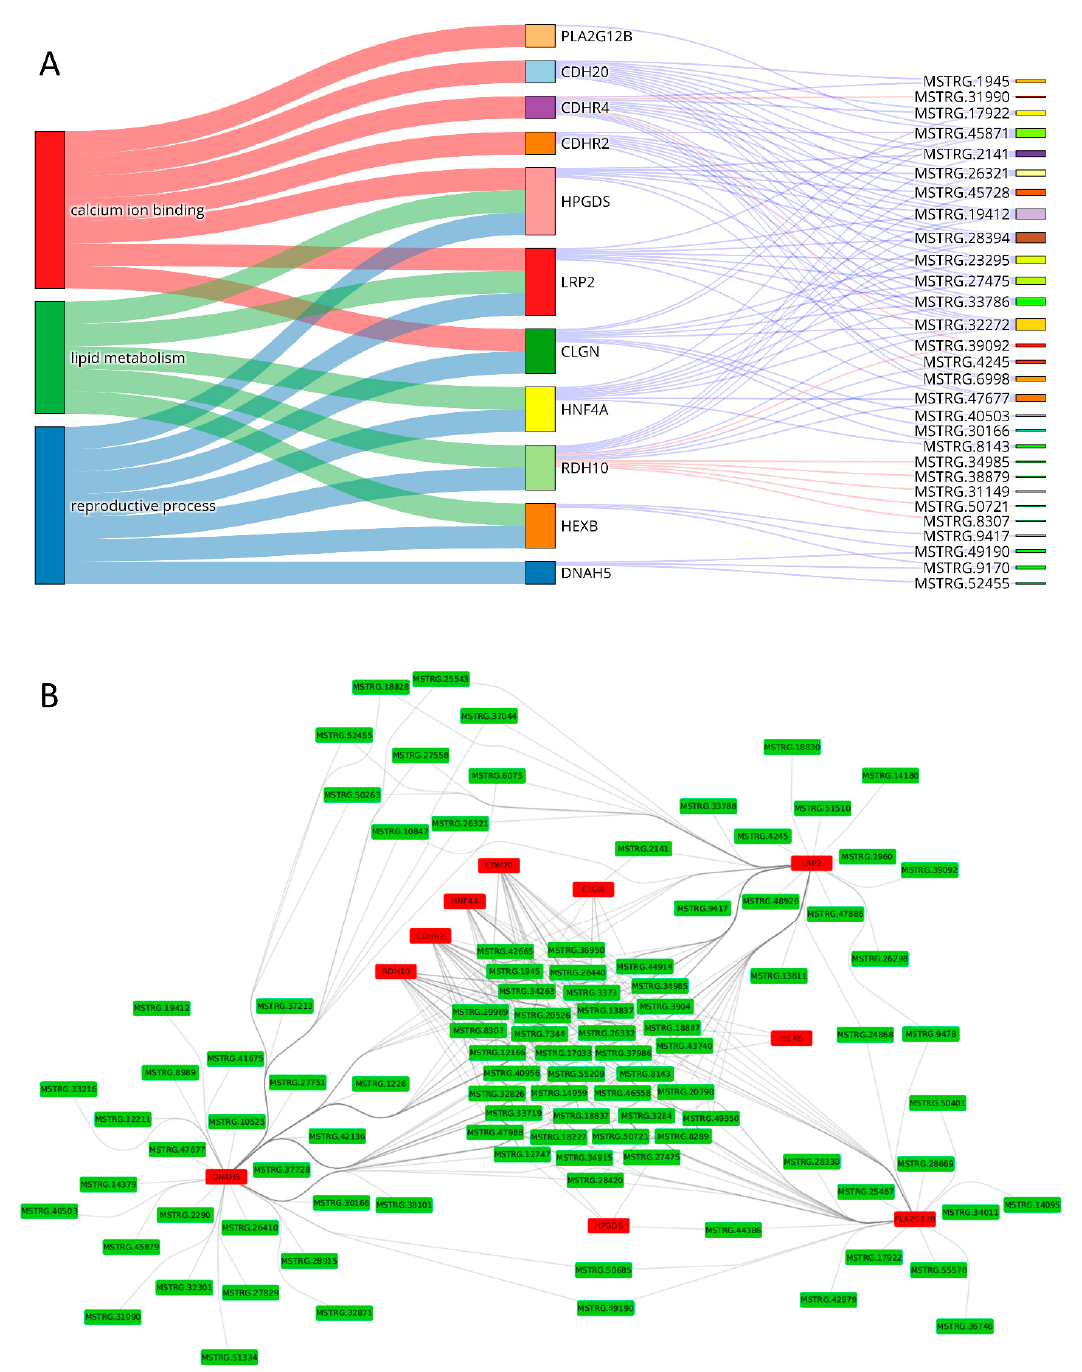
Figure 6. Trans-correlations ( A ) and direct lncRNA-mRNA interactions ( B ) identified in the group of processes with significantly expressed genes between DEGs and DELs associated with the E/(T + DD) group of molecular functions (see Table 4 and Figure 4). The first column in Figure A represents the biological processes. The second column shows the genes associated with the processes in the first column (the lines of the Sankey plot colored corresponding to the processes represent the gene– process relationship). The third column presents lncRNAs, and the lines connecting them with genes symbolize the expression correlation (blue—positive correlation, red—negative correlation). The green color in Figure B indicates lncRNAs, and red indicates the protein-coding genes. The lines symbolize the predicted direct interactions of the